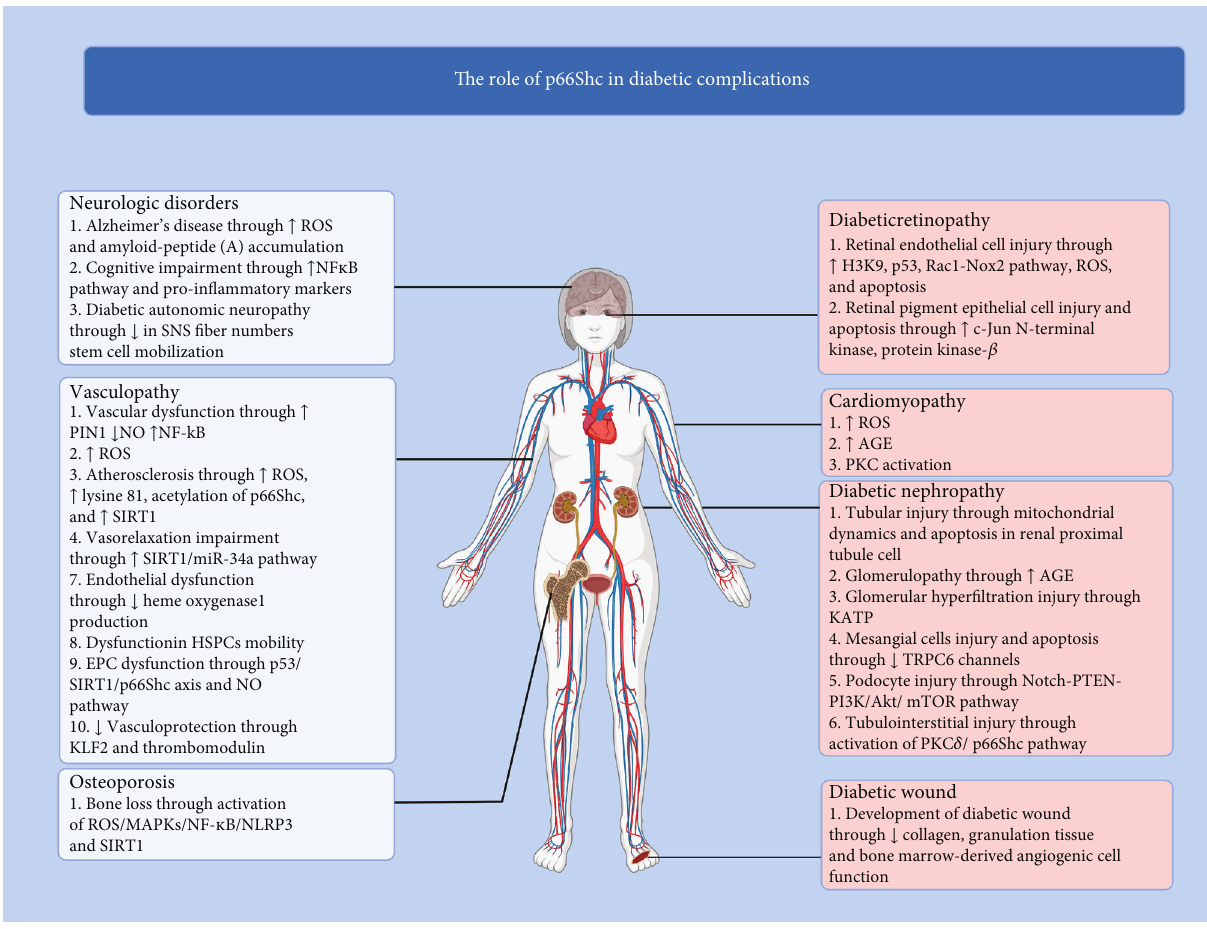
Figure 2: A summary of diabetic complications and the role of